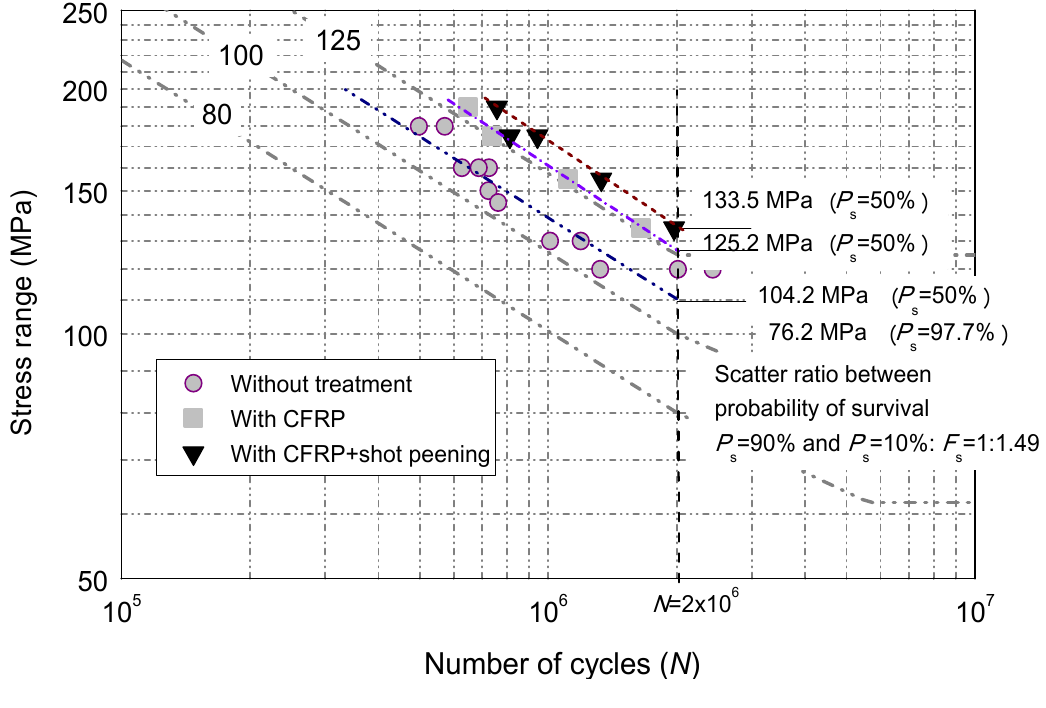
Figure 6. Comparison of fatigue test results. Table 2. Comparison of S - N relations with referred fatigue categories.